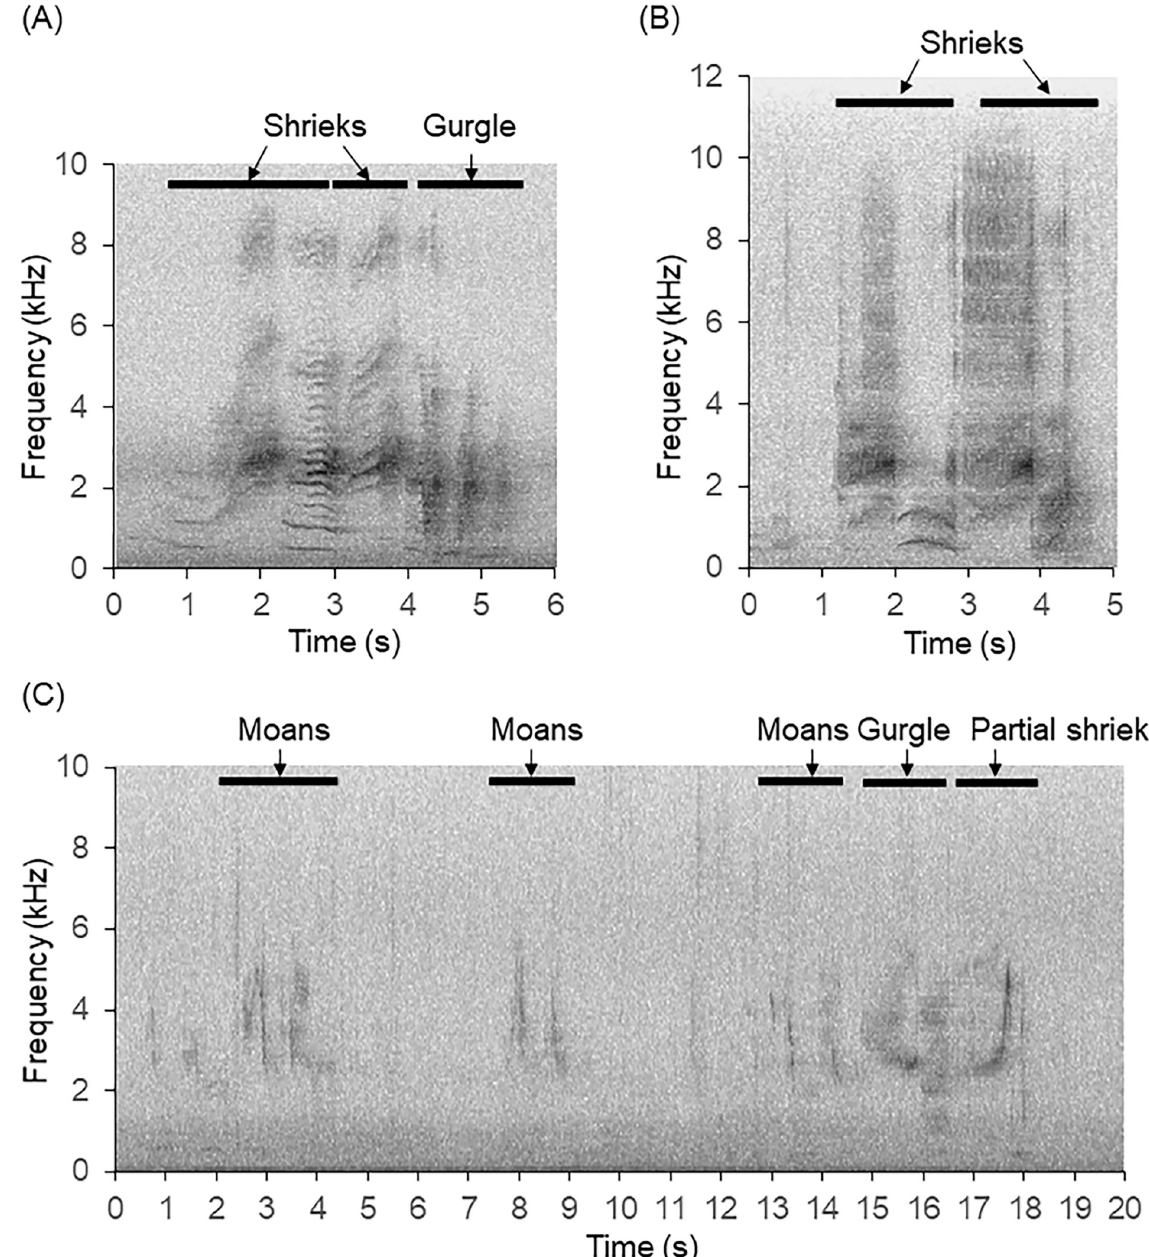
Fig 1. Spectrograms showing the variation in Yellow-bellied Glider vocalisations, including (A) full vocalisations comprising two shrieks and a long gurgle, given when not gliding, (B) non-gliding shrieks only, and (C) several moans, usually given just after gliding out of a tree, followed by a partial shriek